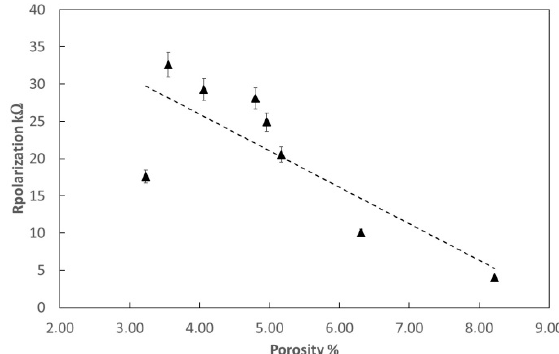
Figure 14. Variation of the polarization resistance as a function of the percentage of porosity for aluminum–bronze coatings.